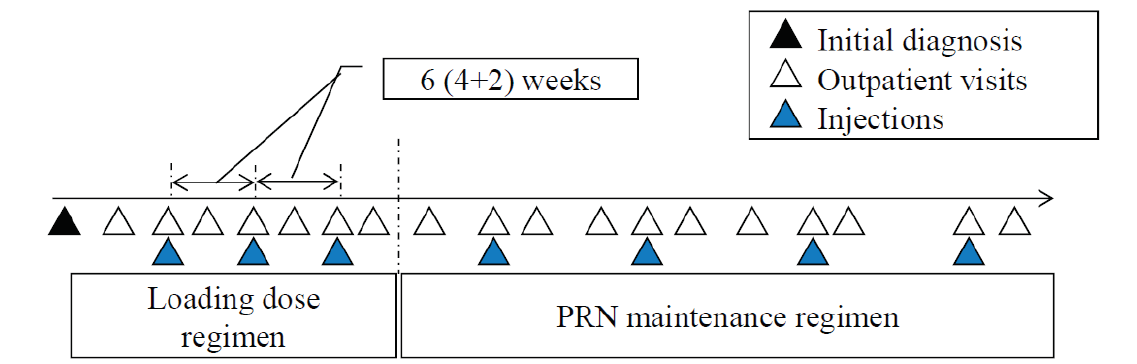
Figure 1. Definitions of the Loading Dose Regimen and the PRN Maintenance Regimen